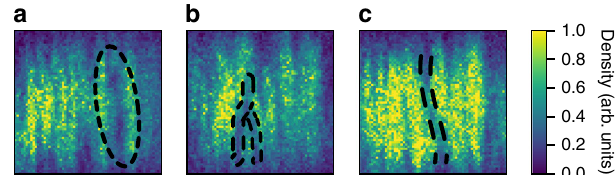
Fig. 5 Experimental evidence of vortex turbulence. The barrier is swept to the center of the BEC in 87 ms ( v p = 2.5 mm s − 1 ). Within the plateau region, a vortex rings, b soliton y-forks, and c soliton snaking are observed. Absorption images are taken after 10.1 ms of free expansion. Black dashed lines are intended as a guide to the